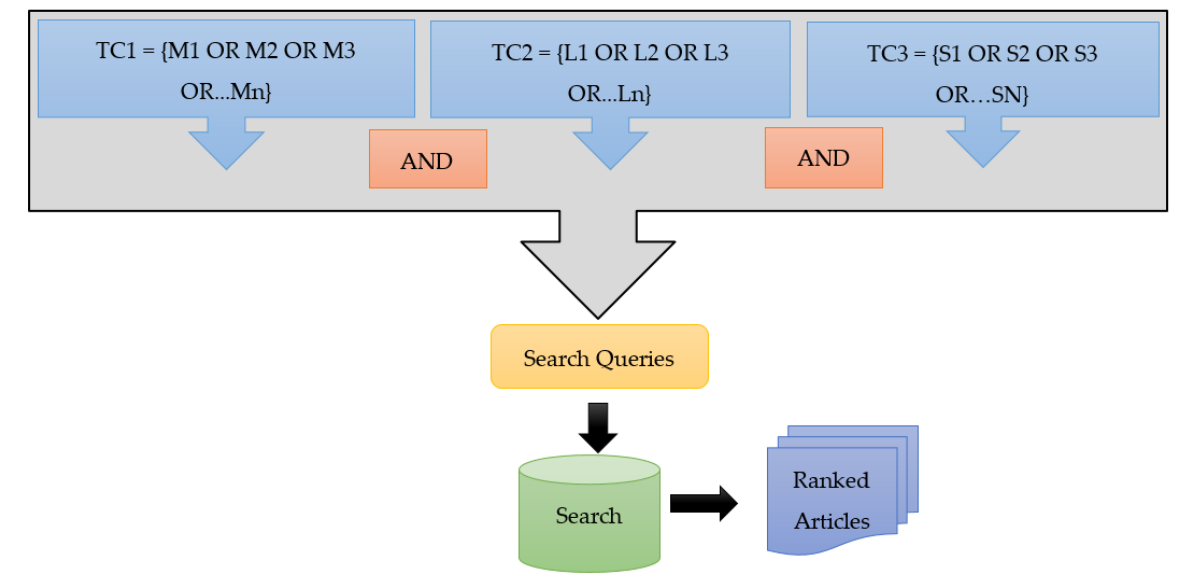
Figure 1. Query formulation for the retrieval of articles.